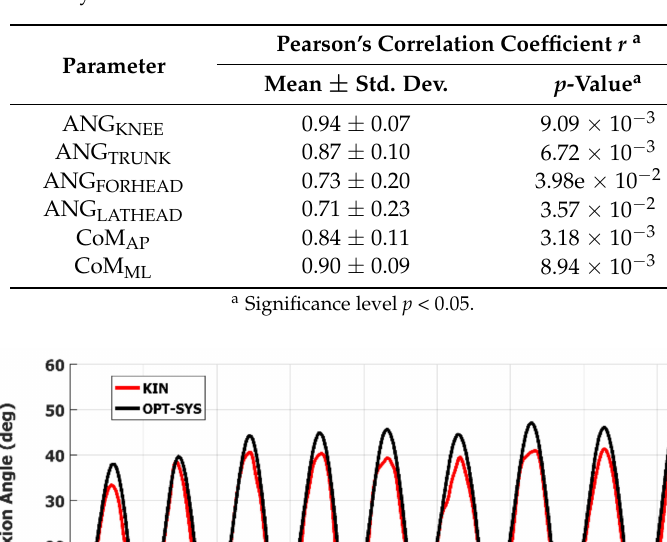
Table 4. Mean and standard deviation of the Pearson’s correlation coefficients for essential parameters estimated by the two systems.